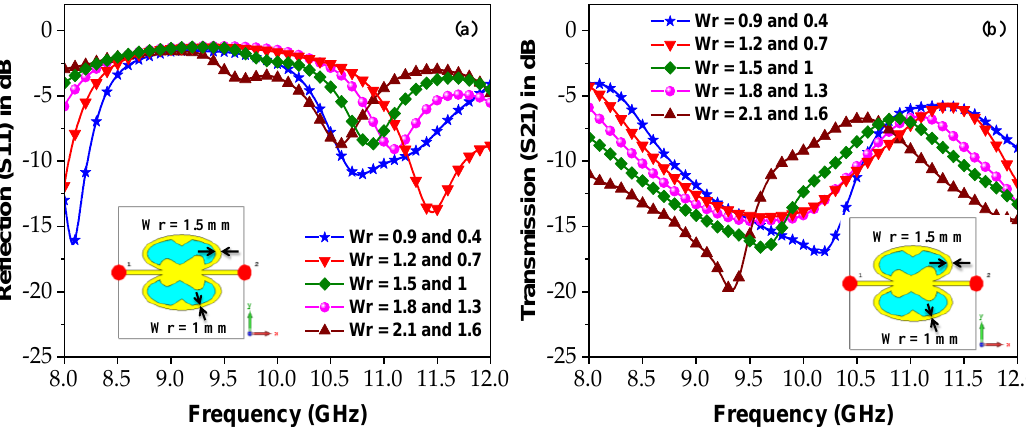
Figure 11. ( a ) Simulated variation effect of width of the resonator layer on the resonant frequency in the reflection and ( b ) transmission spectra.